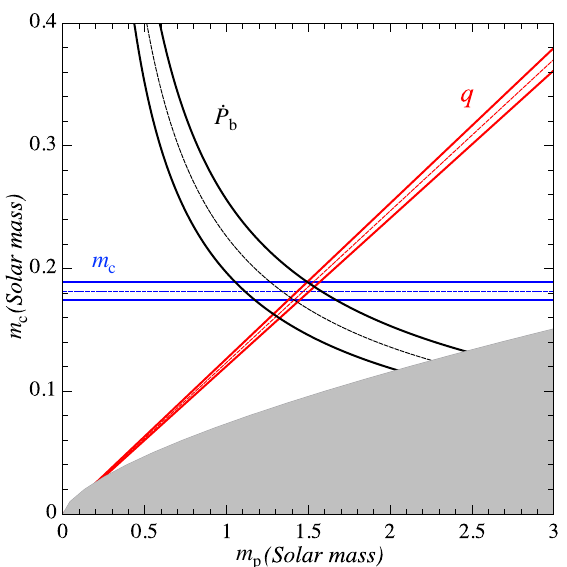
Figure 4. Mass-mass diagram for PSR J1738 + 0333 based on GR. All three curves (companion mass m c , mass ratio q , and GW damping ˙ P b ) agree on a common range of pulsar and companion masses (solid lines indicate the one-sigma range). The grey area is excluded by the mass function and the condition i ≤ 90 ◦